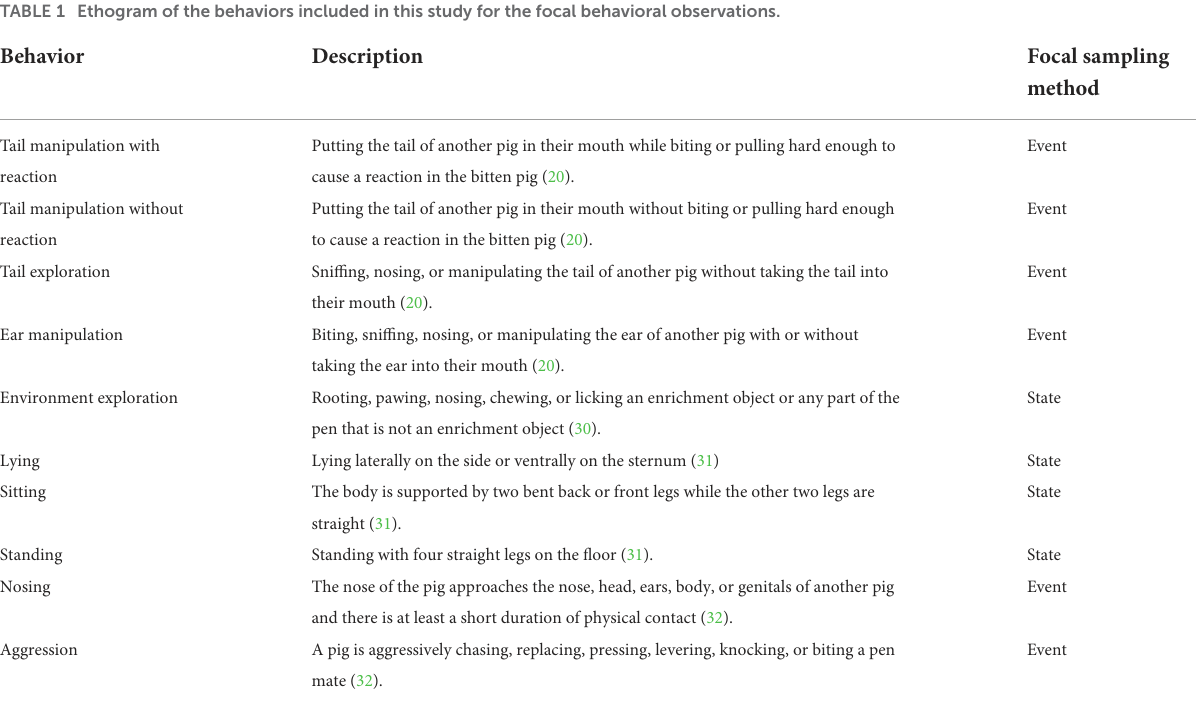
TABLE 1 Ethogram of the behaviors included in this study for the focal behavioral observations. Behavior Description